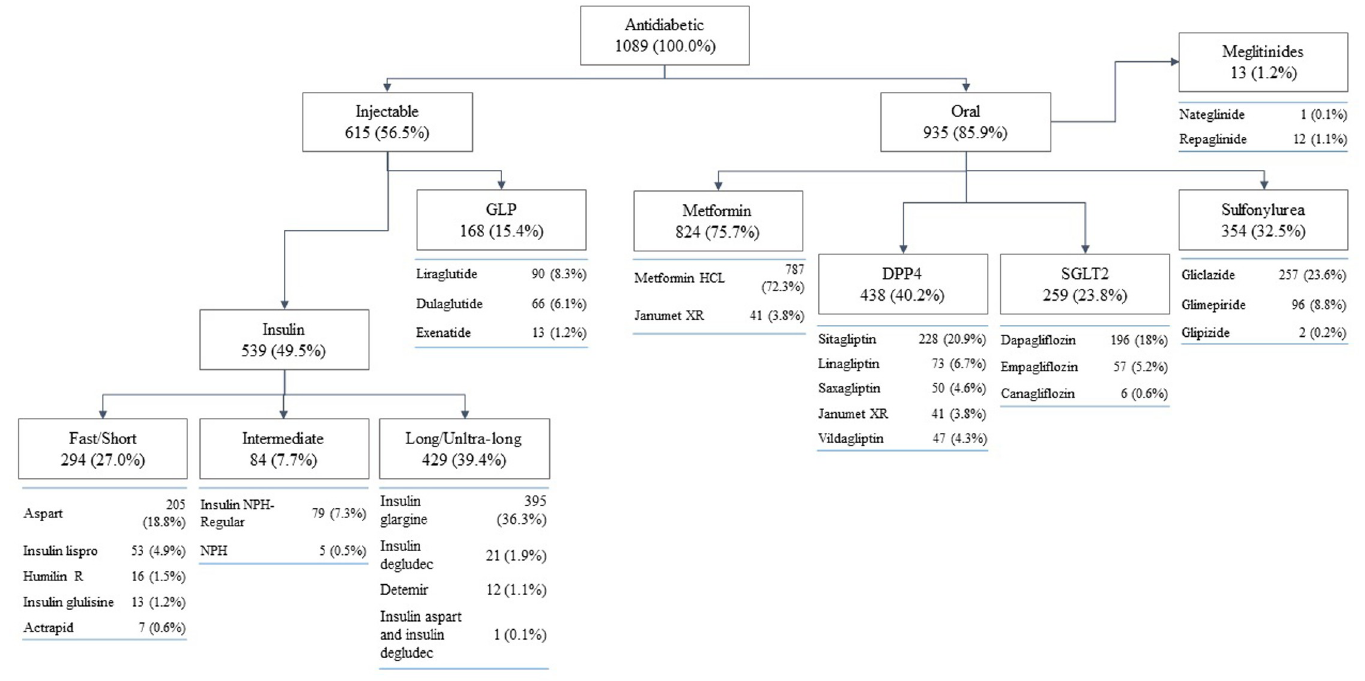
Fig 3. Flowchart showing the utilization of antidiabetics by drug